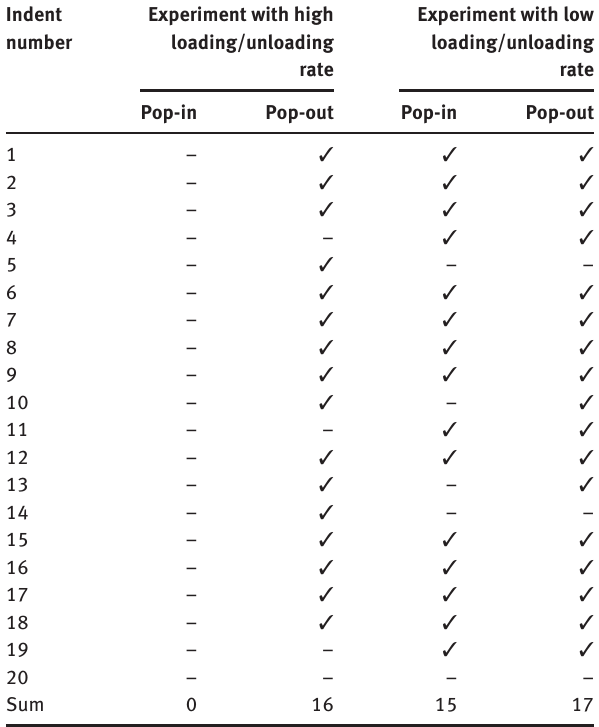
Table 3: Table summarizing the appearance of pop-ins and pop- outs, in monocrystalline silicon for experiments with high loading/ unloading rate (80 mN/min) and low loading/unloading rate